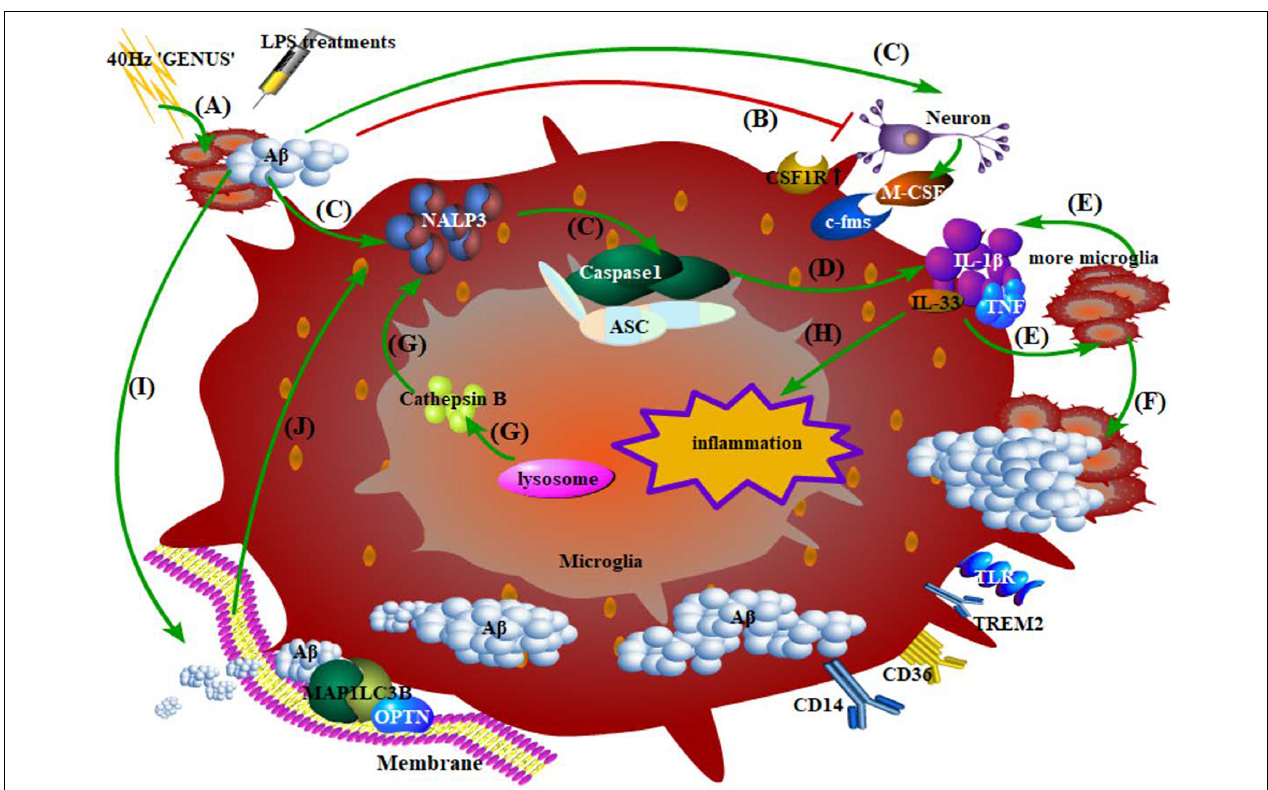
FIGURE 4 | Phagocytosis, degradation of A β by microglia, and the inflammatory response. (A) 40 Hz “GENUS” induces A β accumulation, while LPS treatments regulate immunologic memory; (B) A β at high concentration directly damages the neurons; (C) early events of microglia-mediated inflammation: A β -induced combination of endogenous substances in neurons and their upregulated receptors on microglia, accumulation of NALP3 inflammasome, and activation of caspase-1 precursor; (D) microglia release inflammatory factors; (E) inflammatory factors recruit more microglia with more production of neurotoxic factors; (F) microglia migrate to, surround, and phagocytose A β ; (G) cathepsin B released from damaged lysosomes in microglia directly reinforces NALP3 accumulation; (H) inflammatory factors produced during this period promote neuroinflammation; (I) A β activates the initiation of autophagy and membrane extension; A β compounds are formed and then degraded via the STK11/PRKAA1 pathway; (J) An outbreak of autophagy, in turn, promotes the accumulation of the abovementioned caspase-1 and certain